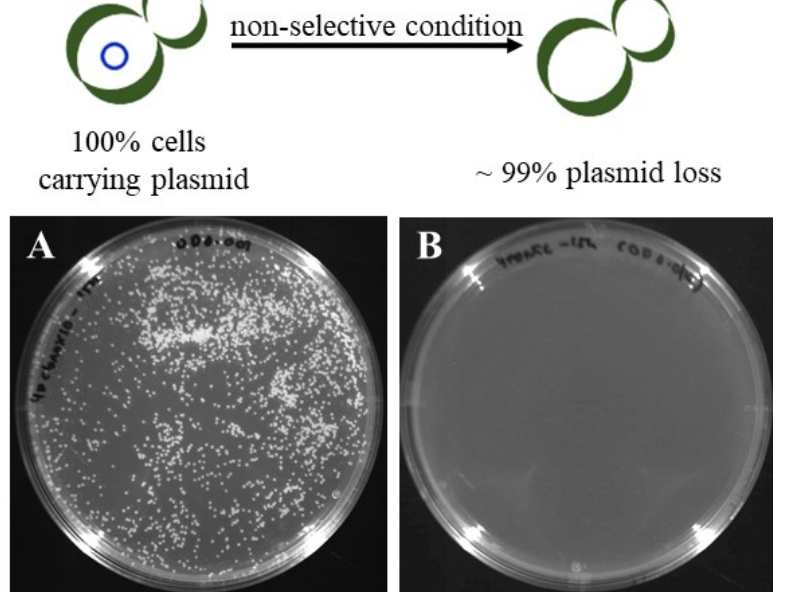
Figure 6. Complete loss of CRISPR-Cas9 plasmid from transformed cells under nonselective condition. Transformed cells harbouring pAN-Cas9gAOX2 vector was cultured in YPD broth without nourseothricin (NTC) for 24 h and an equal amount of cells was plated on YPD ( A ) and YPD + 20 µg/mL NTC ( B ) plate.